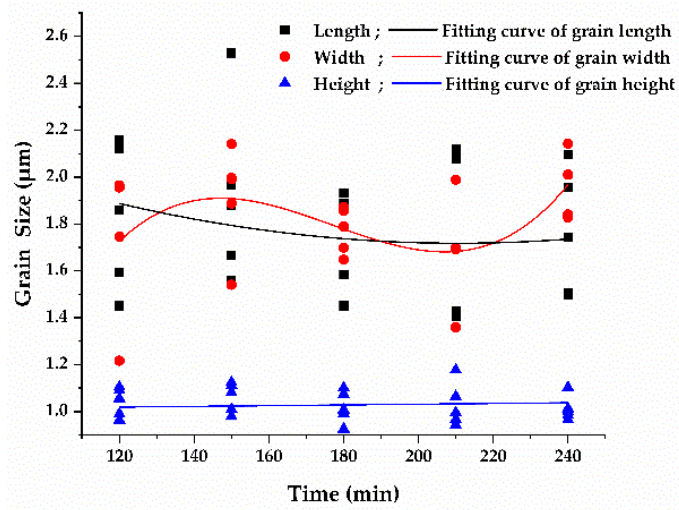
Figure 3. Effect of sputtering time on active abrasive size.